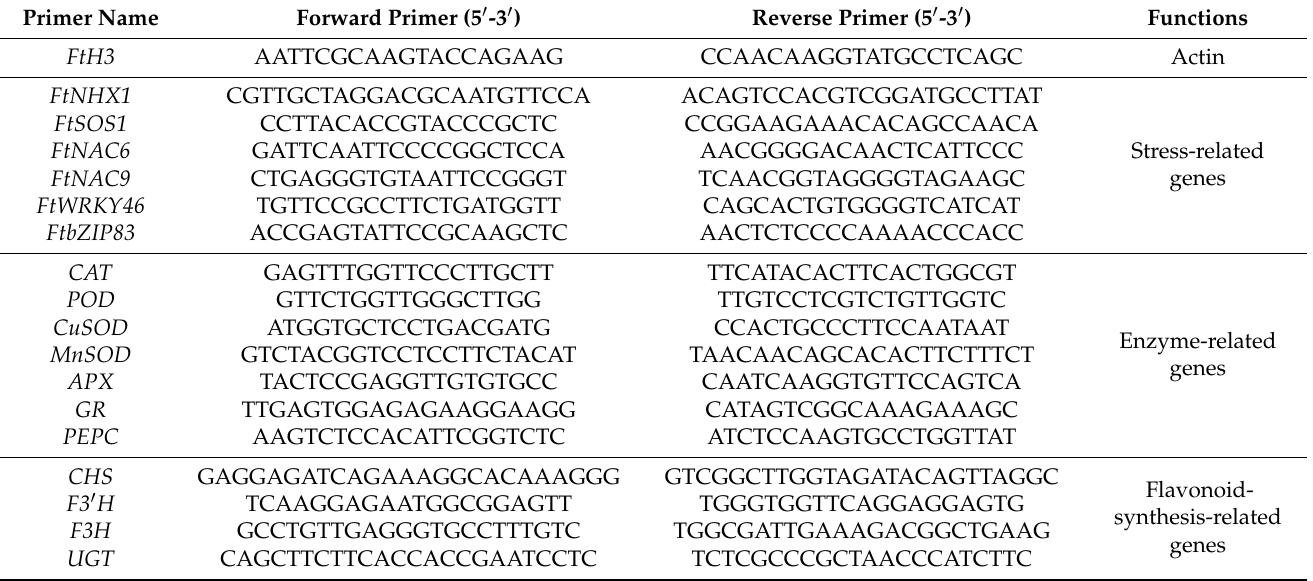
Table 1. The primer sequences for